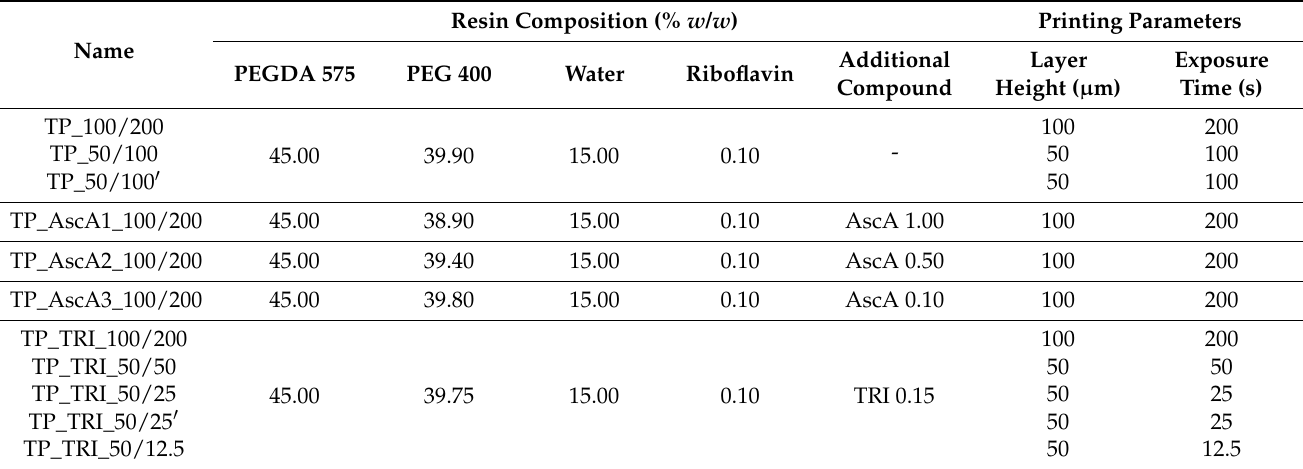
Table 2. Placebo tablet composition and printing